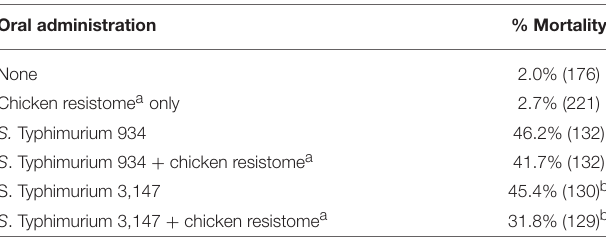
TABLE 8 | Mortality in chickens orally inoculated with nalidixic acid, rifampicin-resistant Salmonella Typhimurium strains.